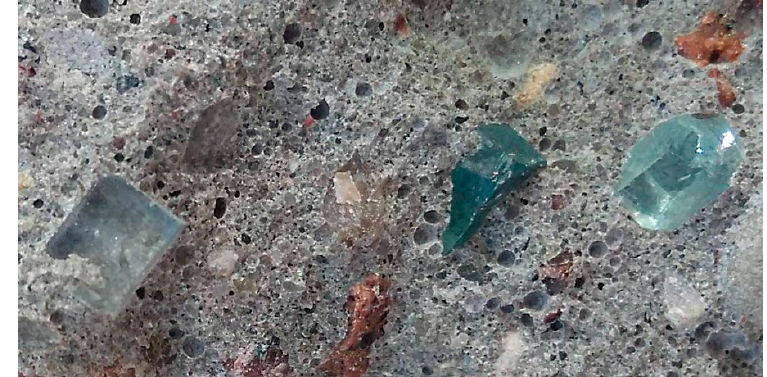
Figure 5. Compressive strength of concrete with RGA; in the form of error bars, the standard deviation is shown.